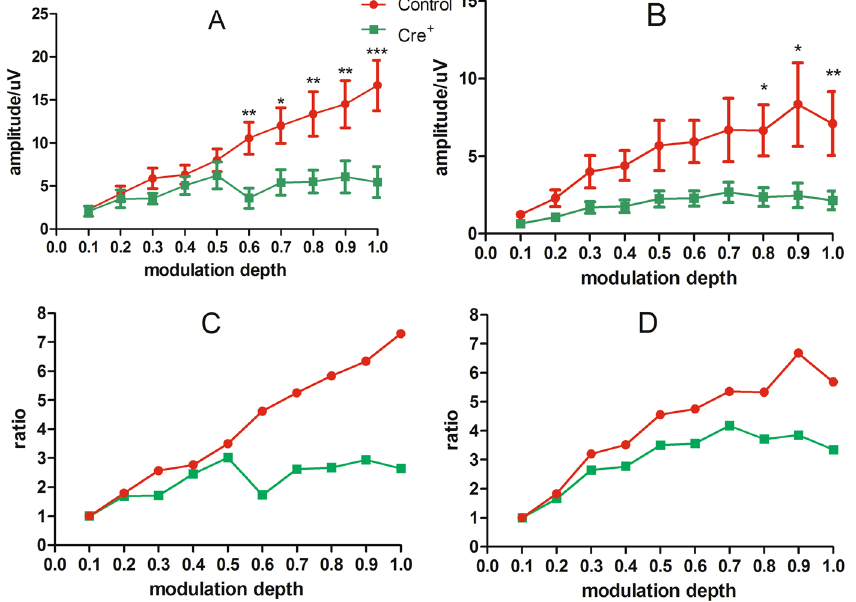
Figure 2. The impact of DT-induced damage on AM response. The frequency of the carrier was 16 kHz. The AM CAP were measured with Fm of 112 Hz ( A , C ) and 996 Hz ( B , D ) respectively, and shown as the amplitude ( A and B ) and ratio change ( C and D ) as the function of modulation depths in percentage. The AM CAP was significantly smaller in Cre + group, especially at larger modulation depth. * p < 0.05, ** p < 0.01, and *** p < 0.001.